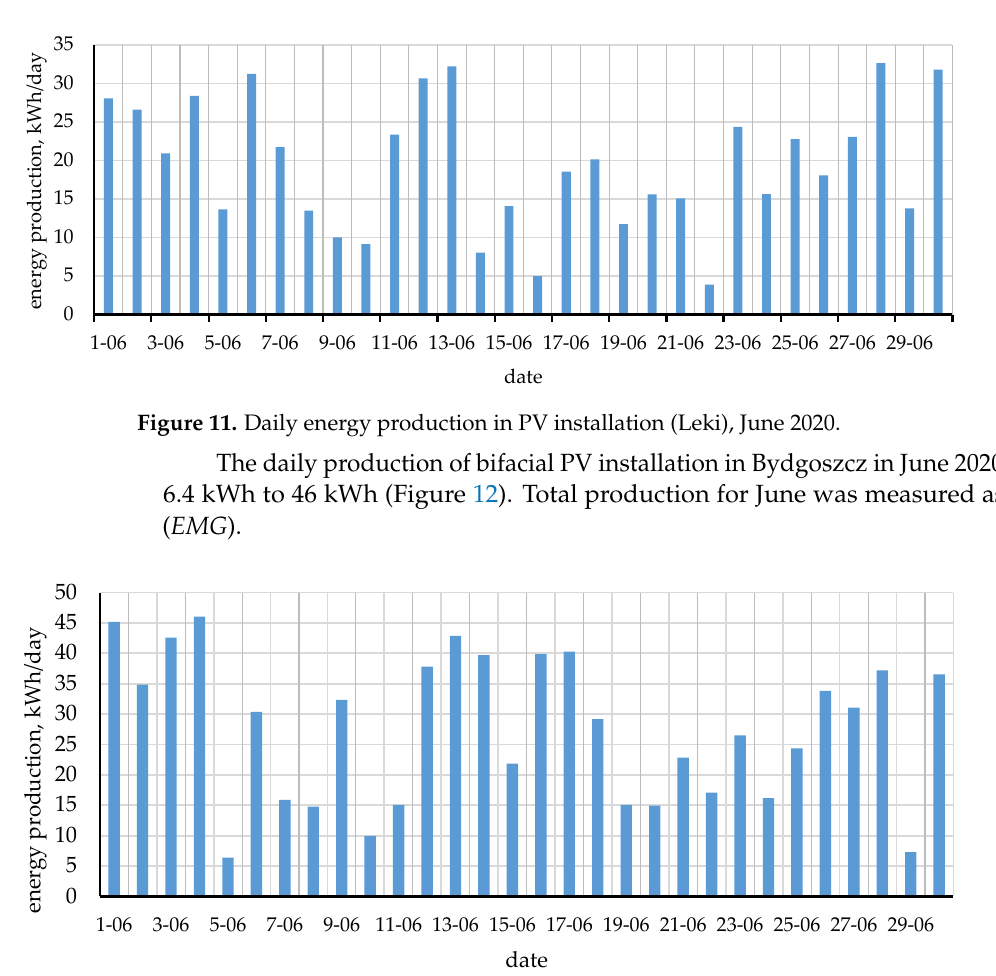
Figure 12. Daily energy production in PV installation (Bydgoszcz), June 2020. The recorded insolation values for each June in 2010–2020 for both locations are pre- sented in Figure 13.